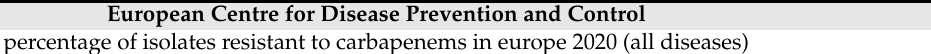
Table 2. Report on the European percentage of carbapenemase-producing pathogens from the European Center for Disease Prevention and Control. In the table the red color gives a visual representation of the percentage of resistance in each